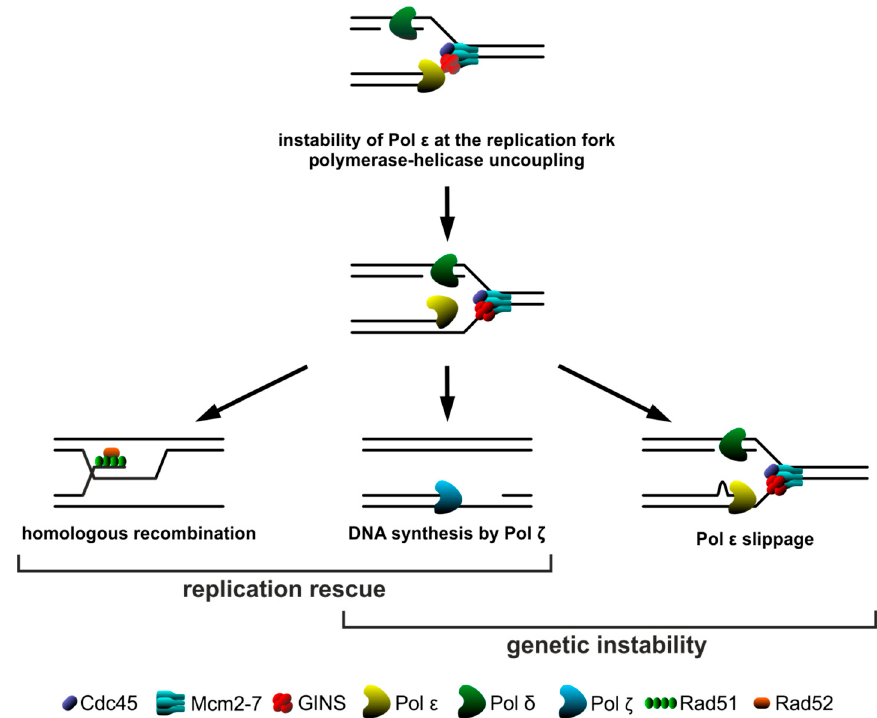
Figure 7. Model showing the consequences of impaired interactions between GINS and Pol ε in the psf1-100 mutant. Defective interactions within the Cdc45, Mcm2–7, GINS, DNA polymerase epsilon (Pol ε ) (CMGE) complex may lead to the instability of leading strand polymerase (Pol ε ) at the replication fork and its uncoupling from the helicase. This may result in polymerase slippage or the formation of single-stranded DNA regions. Restart and continuation of DNA synthesis may be ensured by homologous recombination mechanisms; alternatively, ssDNA gaps may be repaired postreplicatively by the error-prone polymerase ζ (Pol ζ ).